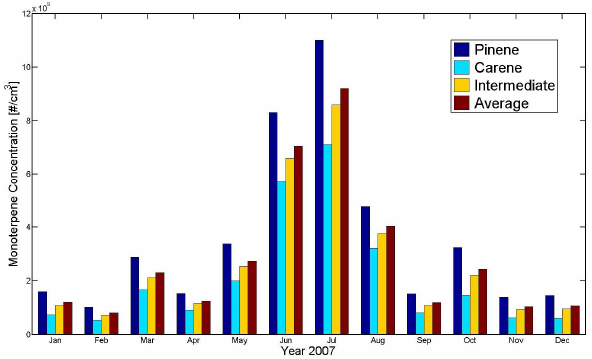
Fig. 9. Modelled monthly mean monoterpene concentrations (moleculescm − 3 ) for the year 2007 at SMEAR II using the emis- sions from Carene, Pinene and Intermediate chemotypes, and the average emission of the population (Table